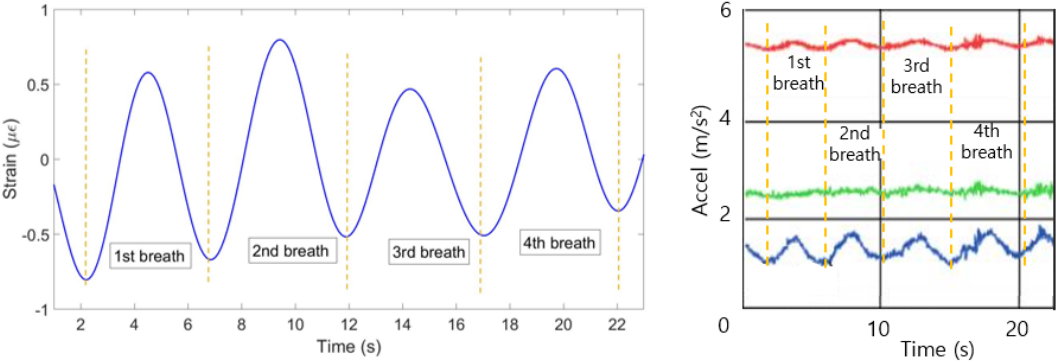
Figure 17. Breathing pattern for the second volunteer in the sitting position reconstructed based on the 10 FBGs strain patterns ( left ) and obtained from the reference sensor ( right